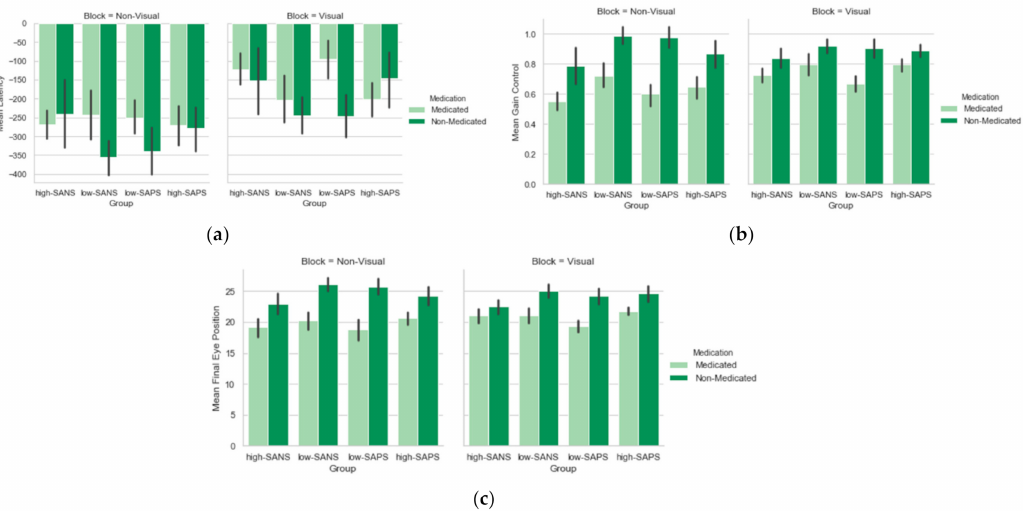
Figure 3. A comparison of the effects of medication on symptomatology between the two blocks in the ( a ) latency, ( b ) gain control, and ( c ) final eye position, measures. Error bars refer to standard